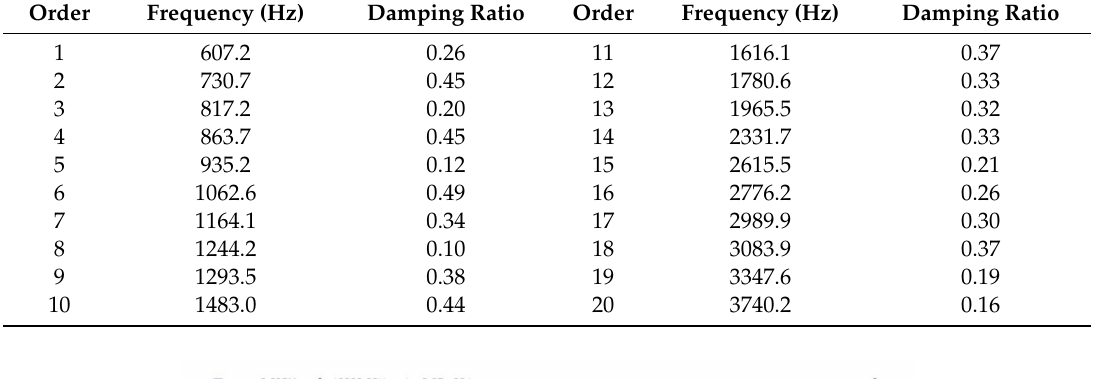
Table 1. The first 20th resonant frequencies and damping ratios.